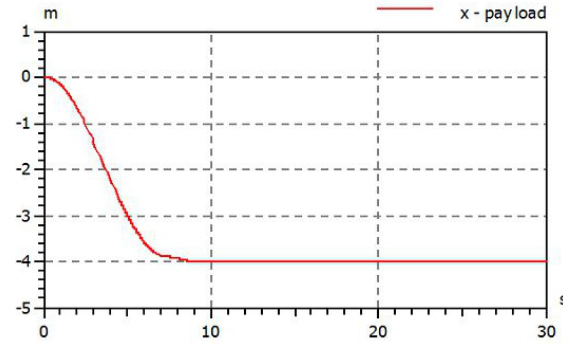
Figure 17. Set point was set to 1 m. Rise time of ca. 3.5 s with no overshoot. Oscillation of ± 1 cm.